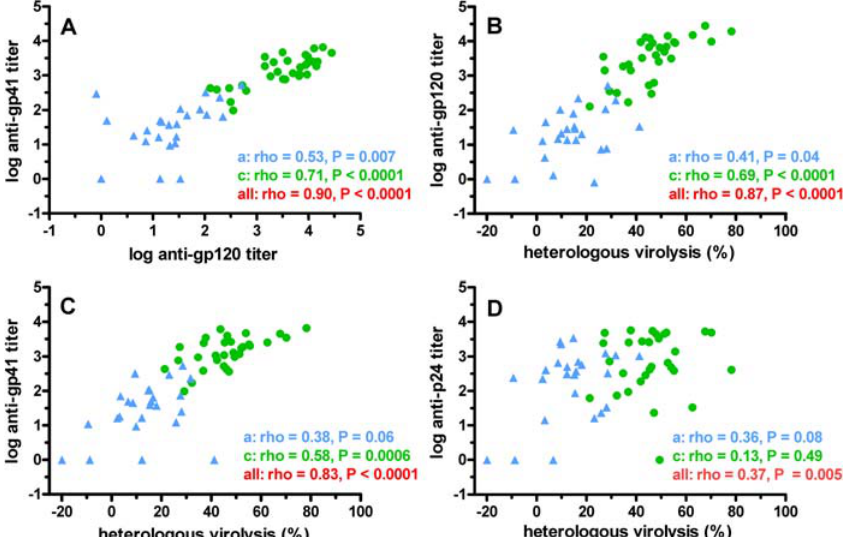
Figure 4. Correlation Analysis of Antibody Responses and Virolysis Activity (A) Correlation analysis of anti-gp120 and anti-gp41 antibody titers in plasma samples from the acute and chronic patient groups shows that titers to the envelope glycoprotein correlate tightly independently of disease stage. (B–D) Correlation analyses of heterologous lysis (JR-FL) with anti-gp120 (B) or anti-gp41 (C) revealed positive correlations, whereas anti-p24 (D) antibody titers did not associate with heterologous lysis. This suggests that lysis activity is driven by envelope-specific antibodies. Blue triangles denote acutely, green circles denote chronically infected patients. Spearman’s rank correlation coefficient (rho) and p -values are depicted for the entire cohort (all), the acute patients (a), and the chronic patients (c). If antibody titers were below 1, the value 1 was used for statistical analysis.